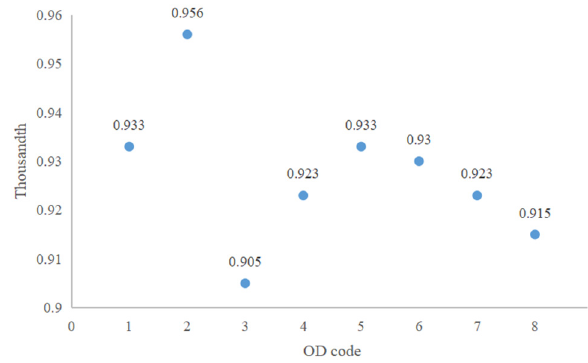
Figure 8. Thousandths of different ODs.